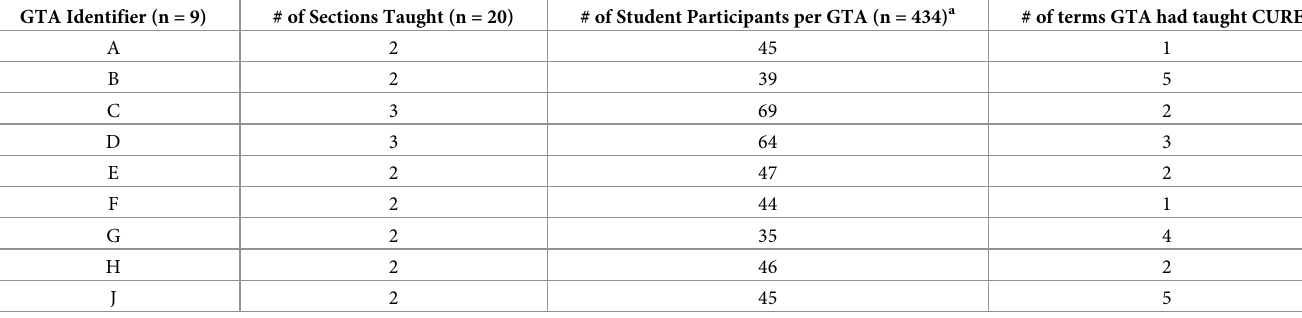
Table 2. Number of sections taught and student study participants for each